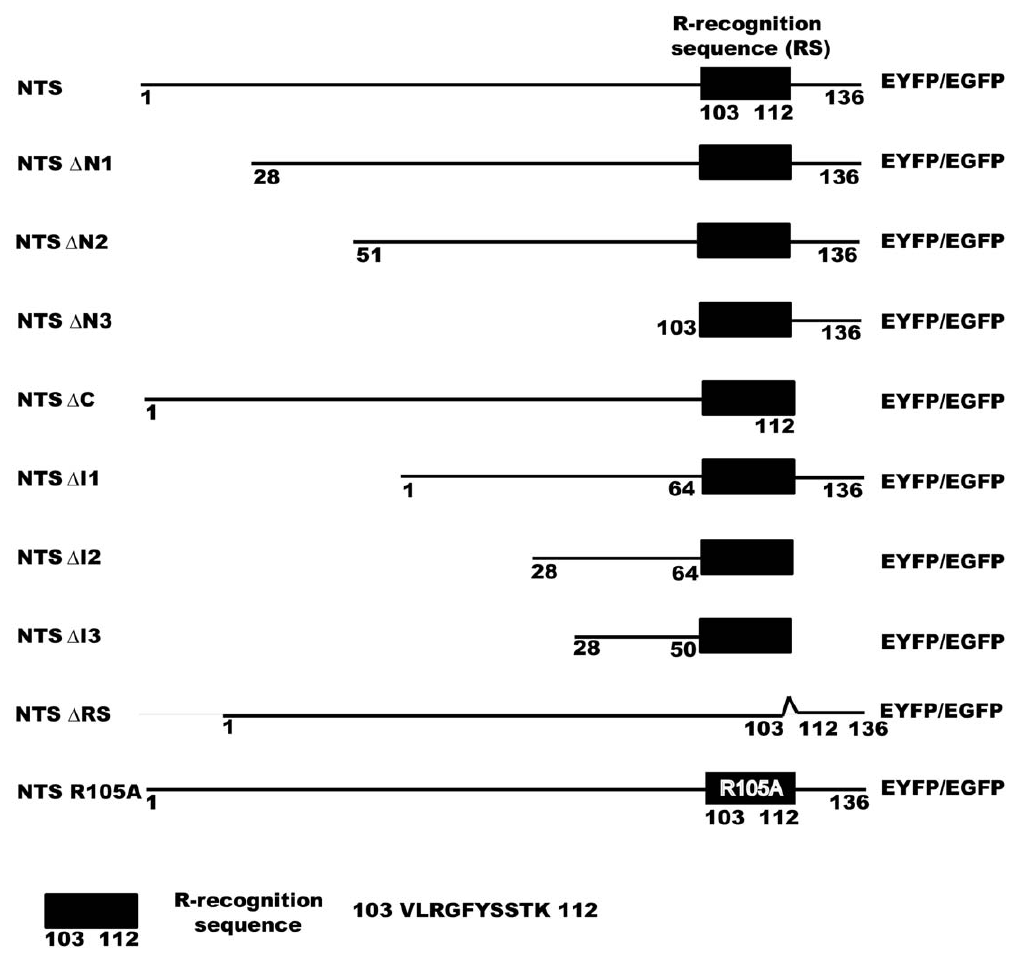
Figure 2. Schematic diagram of dynamin B NTS constructs. Ten different dynamin B NTS constructs are shown. Black bar represents R-like recognition sequence which comprises residues 103 to 112 of NTS.